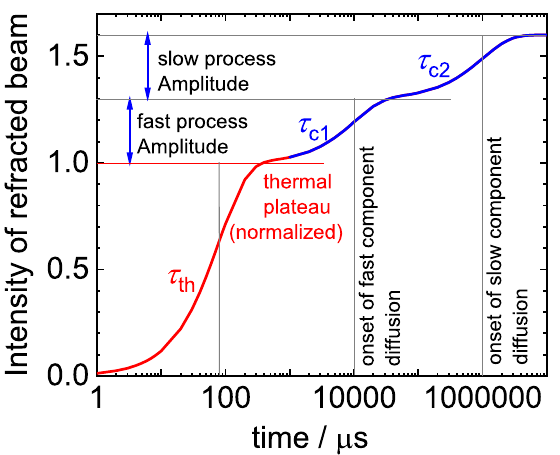
Figure 1. Schematic diagram of the heterodyne intensity of the diffracted beam for a ternary mixture against time. We can differentiate the thermal (red) and the concentration (blue) part of the signal. The three time constants τ th , τ c1 and τ c2 describe the equilibration of the temperature, the solvent and the solute diffusion according to Equation (5). For a binary mixture we would observe only one mode of the concentration signal (blue) as described in Equation